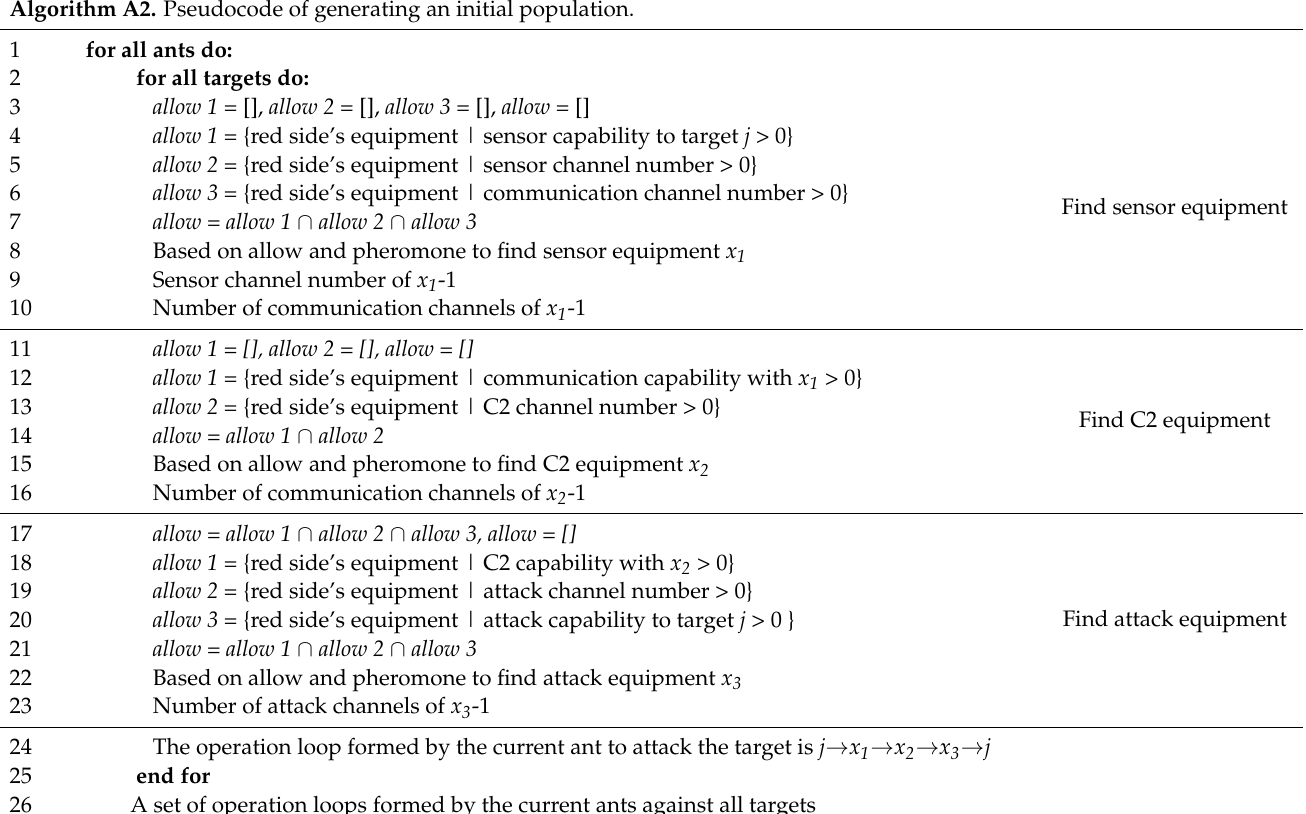
Algorithm A2. Pseudocode of generating an initial